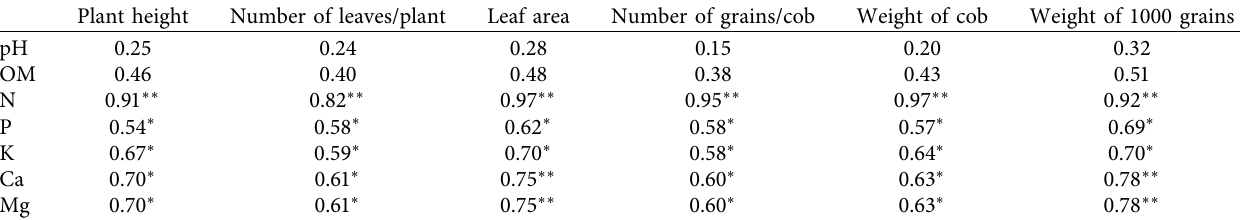
Table 4: Correlation coefficient between growth and yield parameters of maize and soil chemical properties (means of Site I and Site II). Plant